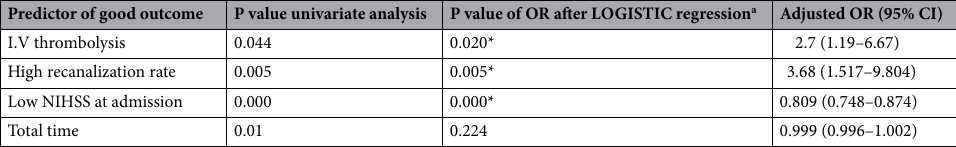
Table 2. Multivariate logistic regression of variables affecting good clinical outcome at day seven. OR odds ratio, CI confidence intervals, OPT onset-puncture time. *Means statistically significant. a Goodness-of-fit was measured by Hosmer–Lehmeshow parameter (P value >